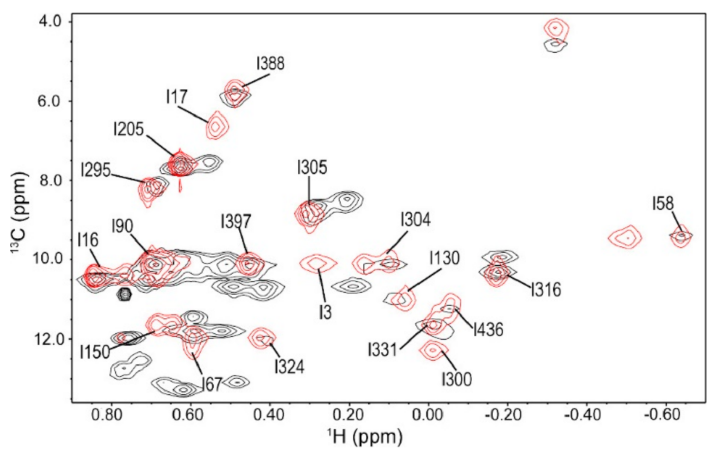
Figure 6. 1 H- 13 C-HMQC Ile methyl NMR spectra of 3D (red) and 3CD (black). 3D numbering is used here for both 3D and the 3D domain in 3CD; to find the corresponding number in 3CD, the reader would need to add